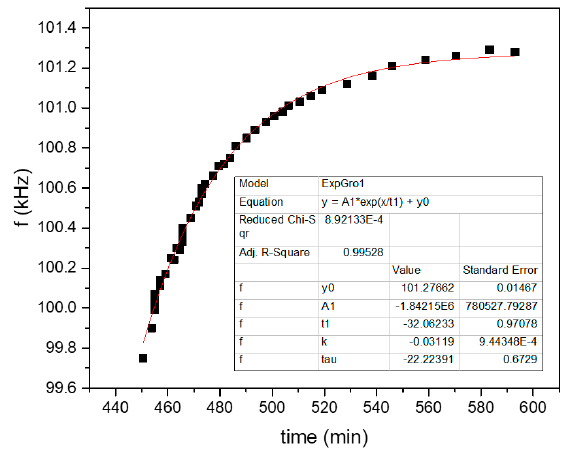
Figure 7. Exponential fit of the second branch marked “AIR” at the plot of Figure 4.